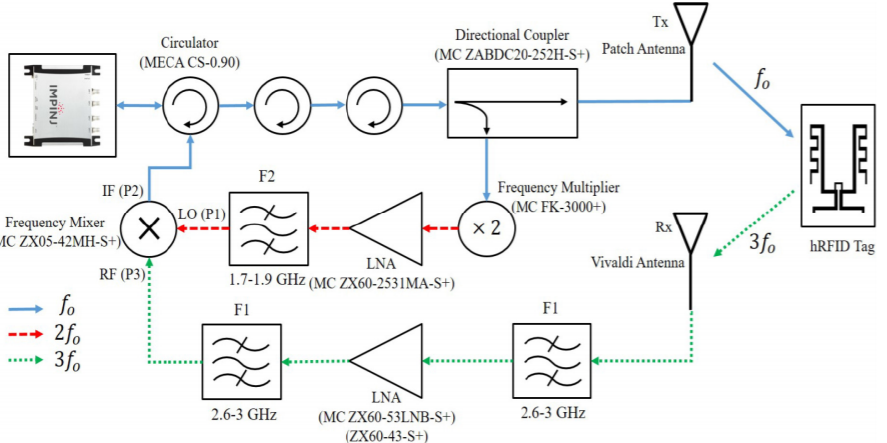
Figure 14. Harmonic RFID reader realization using conventional RFID reader as in [73]. [Reproduced with permission from D. Kumar, Harmonic RFID communication using conventional UHF system; published by IEEE,